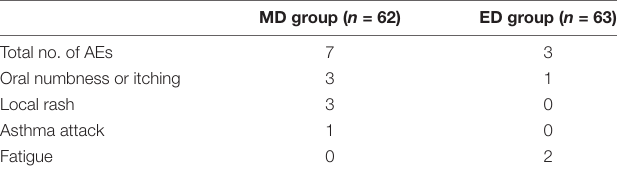
TABLE 2 | Reported AEs in the